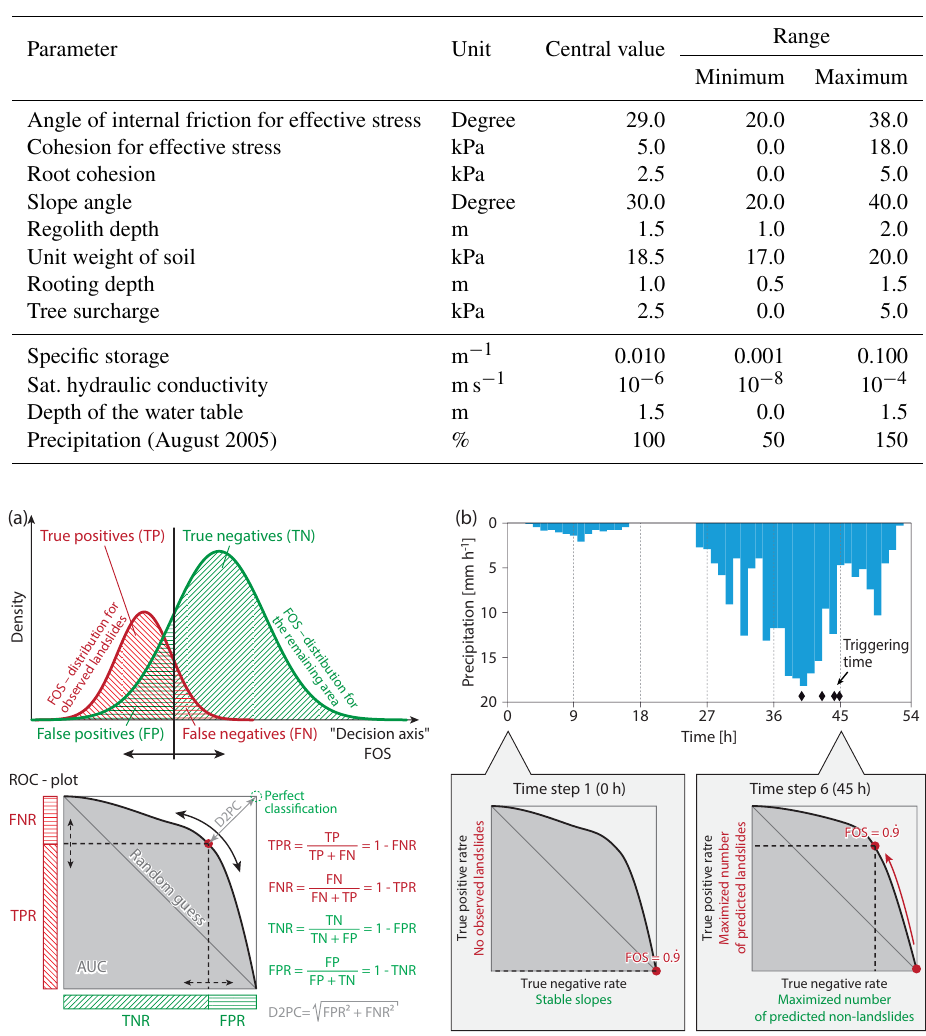
Figure 7. Principle of the receiver operating characteristic ( a ; modified after Metz, 1978) and its application in the calibration procedure (b) . FOS: factor of safety; TPR: true positive rate; FNR: false negative rate; TNR: true negative rate; FPR: false positive rate; D2PC: distance to perfect classification; AUC: area under the ROC